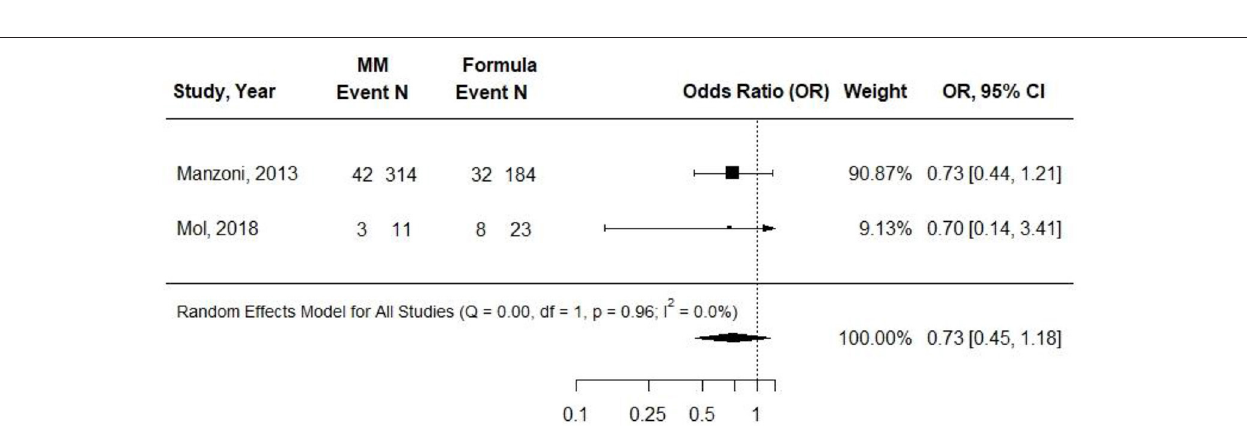
FIGURE 3 | Forest plot demonstrating OR (95%CI) of sepsis for VLBW preterm infants receiving ≥ 75% intake from MM compared to exclusive formula